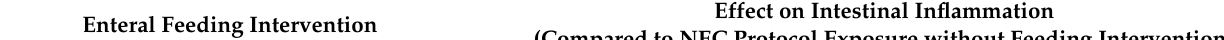
Table 6. Effect of enteral feeding interventions that reduce intestinal inflammation in experimental animal models of NEC. Enteral Feeding